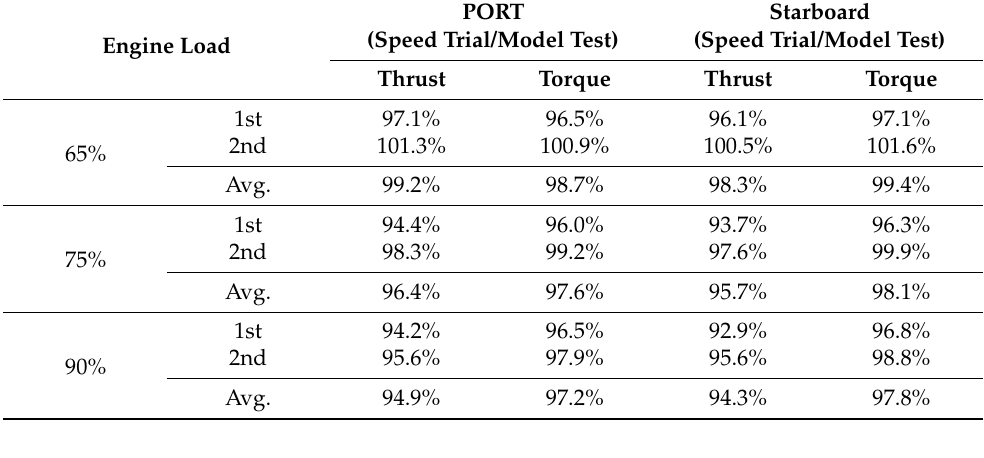
Table 5. Difference ratio between speed trial measurement and prediction results based on the model test of the twin skeg LNG carrier.